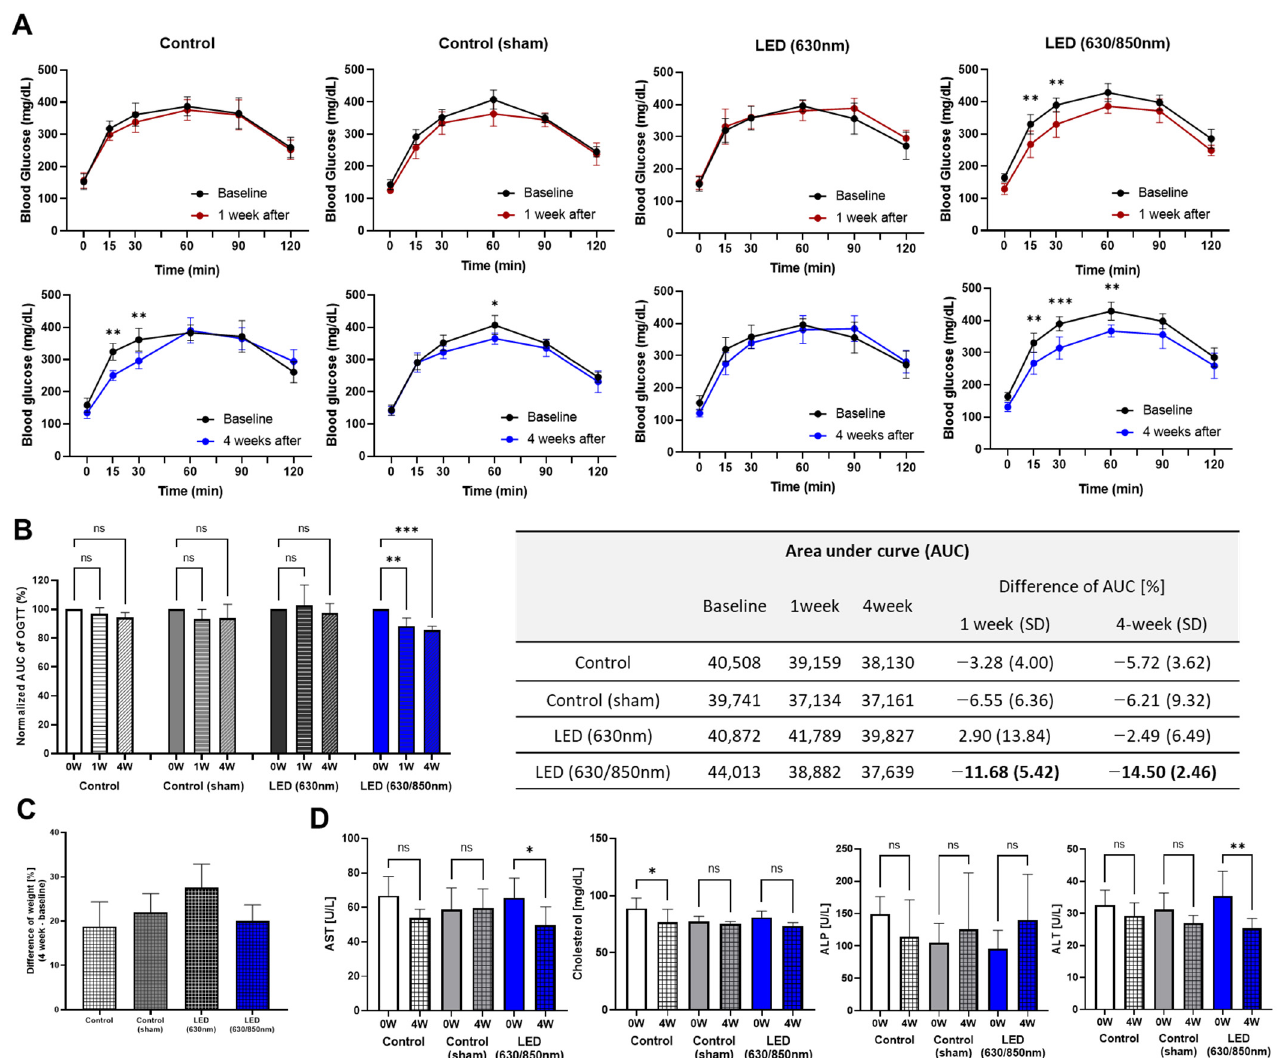
Figure 2. Effects on metabolic improvement in the 4-week follow-up study with duodenal dual- wavelength (D) photobiomodulation (PBM) with light-emitting diode (LED): Glycemic curves ( A ) during oral glucose tolerance test (OGTT) and normalized area under the curve ( B ) showing the comparison of 0 versus 1 week after PBM, and 0 versus 4 weeks after PBM in control, sham control, PBM with 630 nm, and PBM with D-LED (630/850 nm) groups. ( C ) The percentage of body weight gain at the end of the experiment in the 4-week follow-up. ( D ) Comparison of the biochemistry parameters of aspartate aminotransferase, alanine aminotransferase, alkaline phosphatase, and cho- lesterol levels in control, sham control, and D-PBM groups between 0 and 4 weeks after PBM. * p < 0.05; ** p < 0.01; *** p < 0.005.